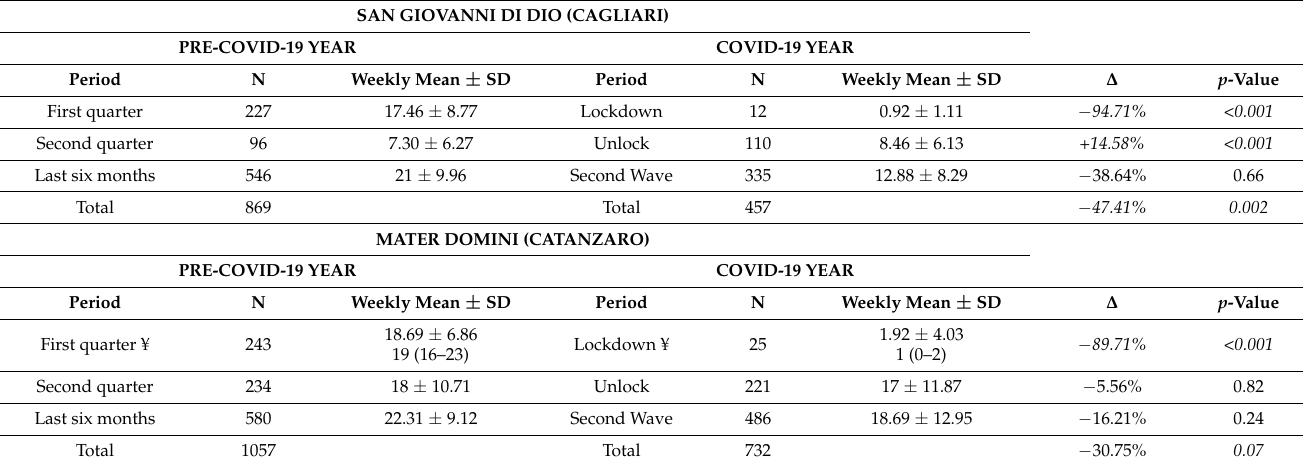
Table 7. Number of cataract surgical procedures performed at San Giovanni di Dio (SGD), University of Cagliari, and Mater Domini, University Magna Græcia of Catanzaro (UMG), divided by periods of lockdown, unlock, and second wave,